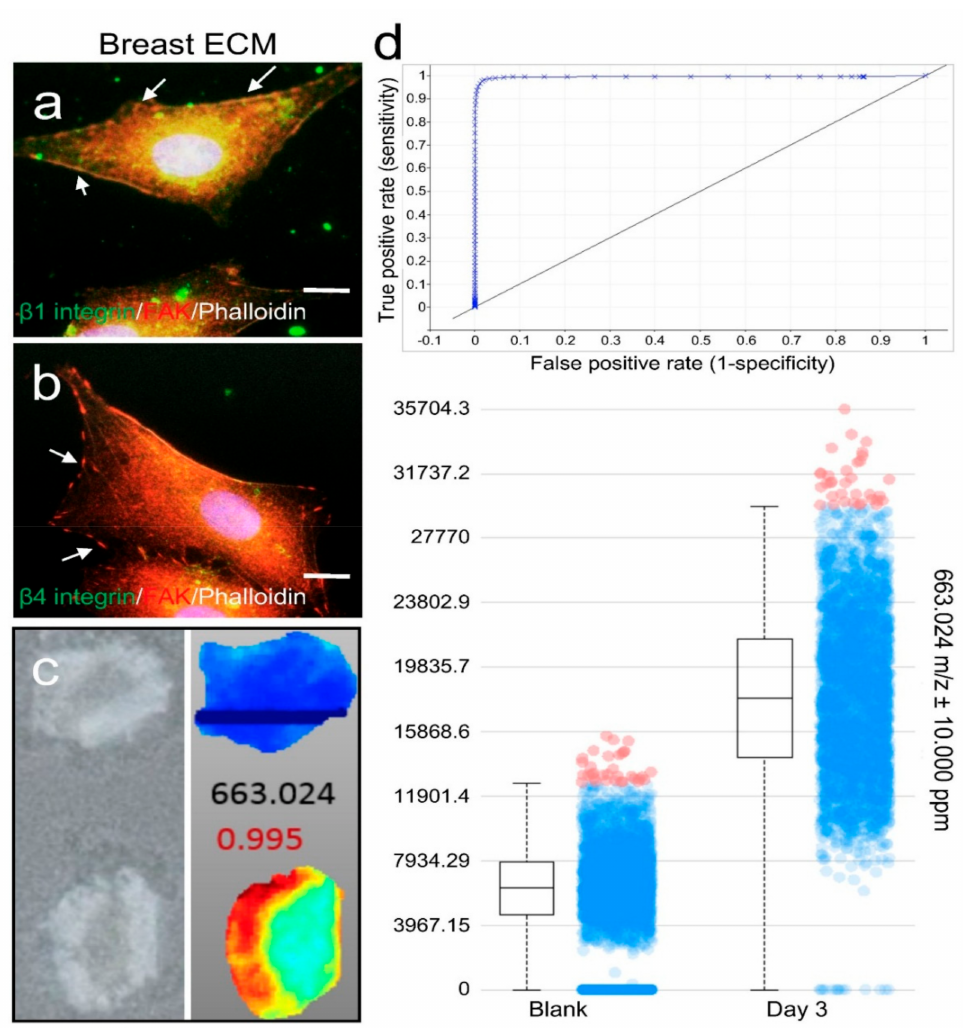
Figure 3. Membrane surface receptor expression and metabolomic analysis of cells grown on porcine breast fatty tissue ECM hydrogel. Integrin β 1 ( a ) or β 4 ( b ) receptor (green) and FAK (red) expression in MM231 cells cultured on the ECM hydrogel-coated coverslips were assessed by IF. Phalloidin staining (white) of F-actin was used to contour the cells. Scale bars, 10 µ m. ( c ) MS imaging of cross sections of the medium-conditioned blank (upper panels) and MM231 cell culture-laden (bottom panels) hydrogel scaffolds. ( d ) Examples of ROC (upper) and box-and-whiskers (bottom) plots from the MS imaging analysis, showing data for a compound with m / z 663.024, where differences between the hydrogel samples cultured with or without MM231 cells are clearly